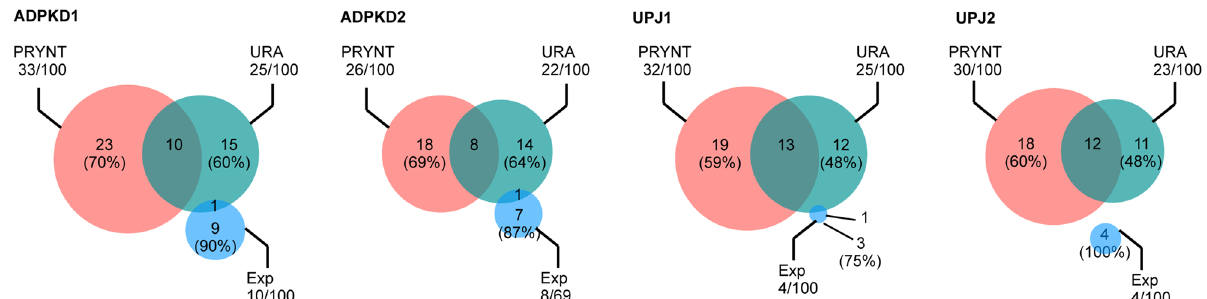
Figure 5. Overlap of reference disease candidates prioritized in the top 100 by PRYNT, URA or Exp. Prioritization by PRYNT, URA or from the experimental urinary proteomic candidates (Exp) was applied and reference ADPKD and UPJ disease candidates ranked in the top 100 were compared in the four datasets. Exp: experimental; URA: upstream regulator